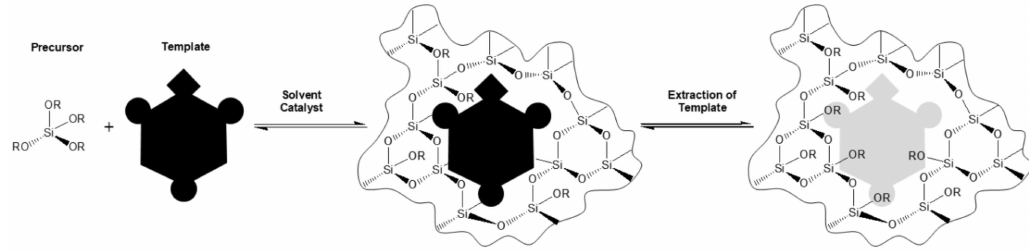
Figure 1. Scheme of sol-gel imprinting